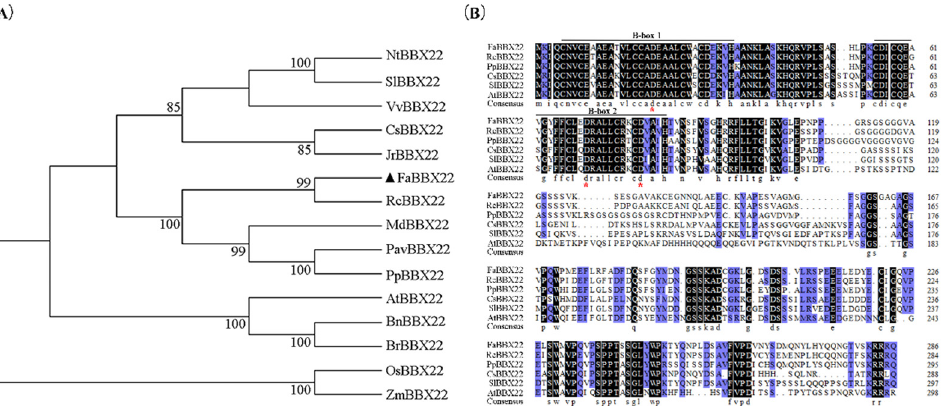
Figure 1. Alignment and phylogenetic tree of FaBBX22. ( A ) The phylogenetic relationships between the BBX22 proteins. The black triangle indicates FaBBX22. NtBBX22 (XP_016460367.1) in Nicotiana tabacum ; SlBBX22 (XP_004244294.1) in Solanum lycopersicum ; VvBBX22 (XP_002283666.1) in Vitis vi-